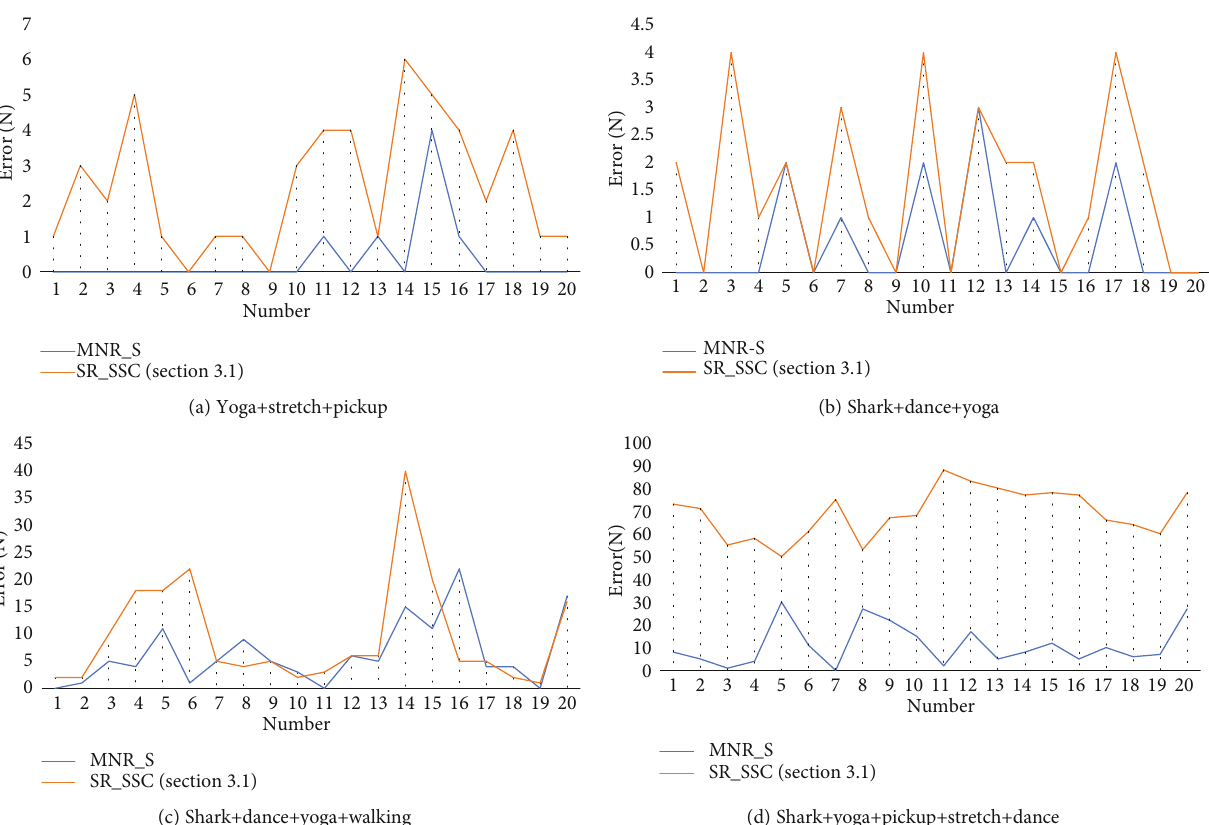
Figure 6: In fl uence of optimisation weight matrix on algorithm performance and comparison of the SR_SSC (Section 3.1) algorithm and ours in 20 experiments on each fl